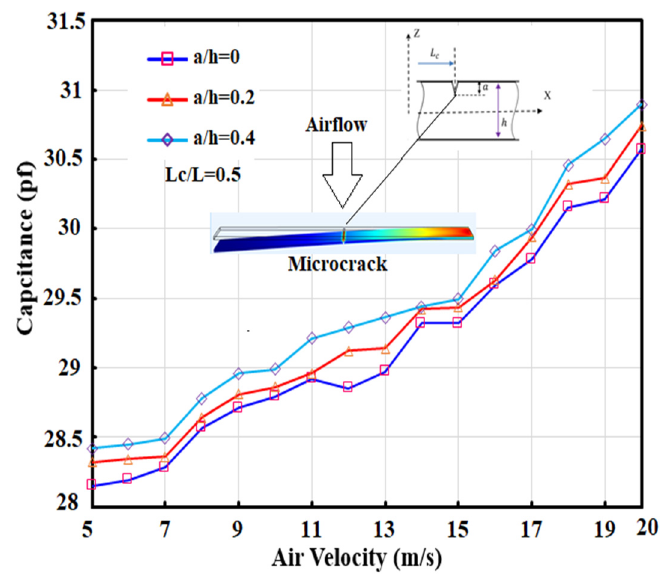
Figure 18. The capacitance output of a cracked microcantilever compared to uncracked MCL. The more the depth of microcrack, the more capacitance there would be. The crack is placed at the middle of microcantilever, and the depth of microcrack varied.